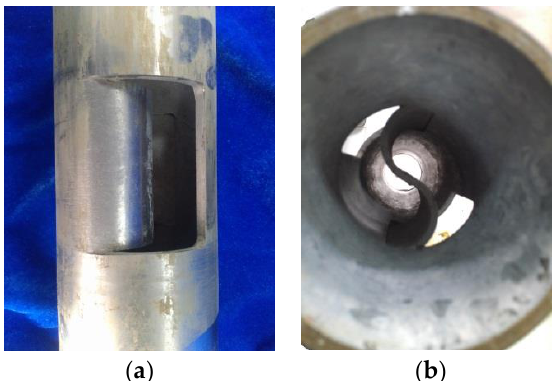
Figure 1. Pile forming mold and structure diagram of the nodular pile: ( a ) side view; ( b ) overhead view.